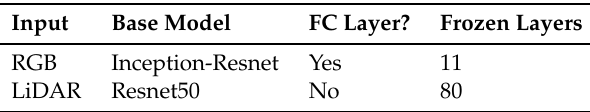
Table 5. Best CNN model architectures.